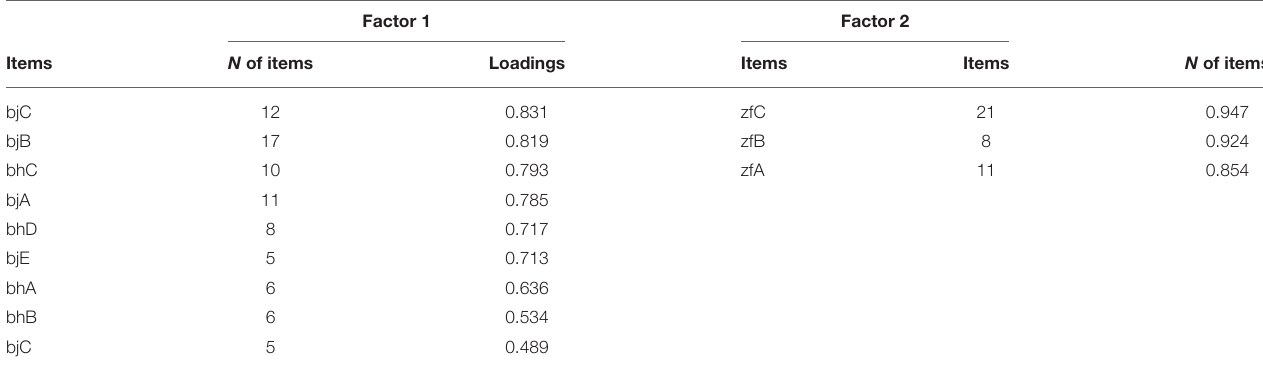
TABLE 4 | Exploratory factor analysis of each factor loading matrix for grades 3–4 scale (120